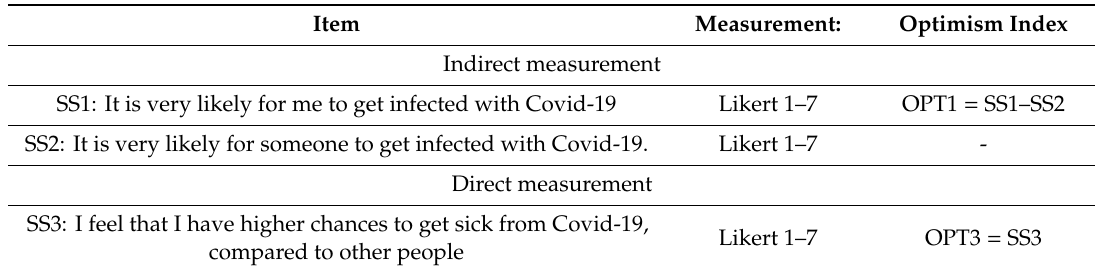
Table 3. Items involved in the optimism bias measurement.